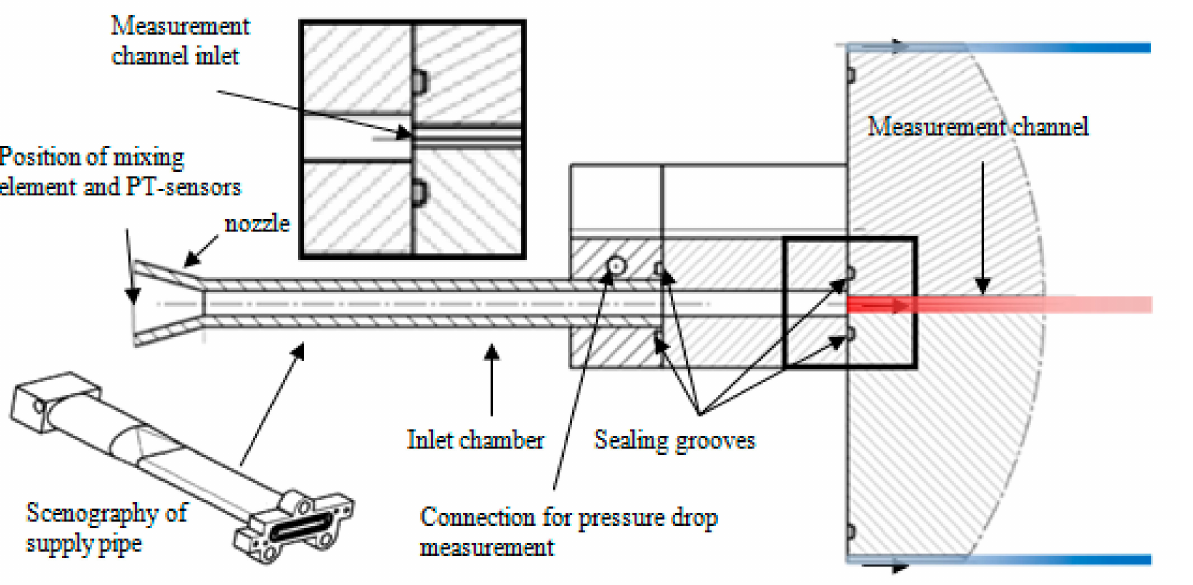
Figure 10. Cross-sectional view of the supply pipe and the beginning of the flat tube measuring channel. Reproduced with permission from [16], published by Elsevier